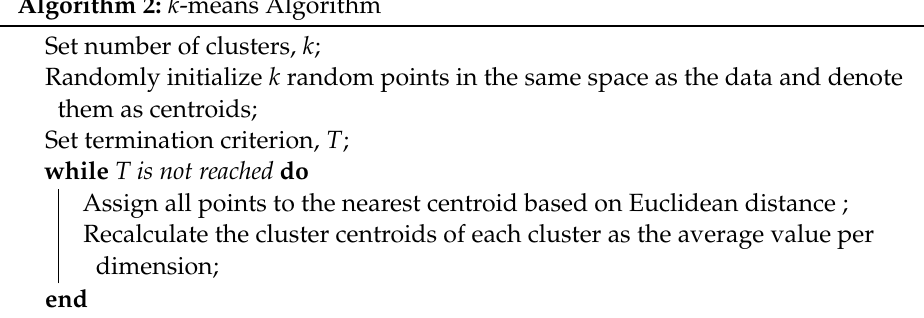
Algorithm 2: k -means